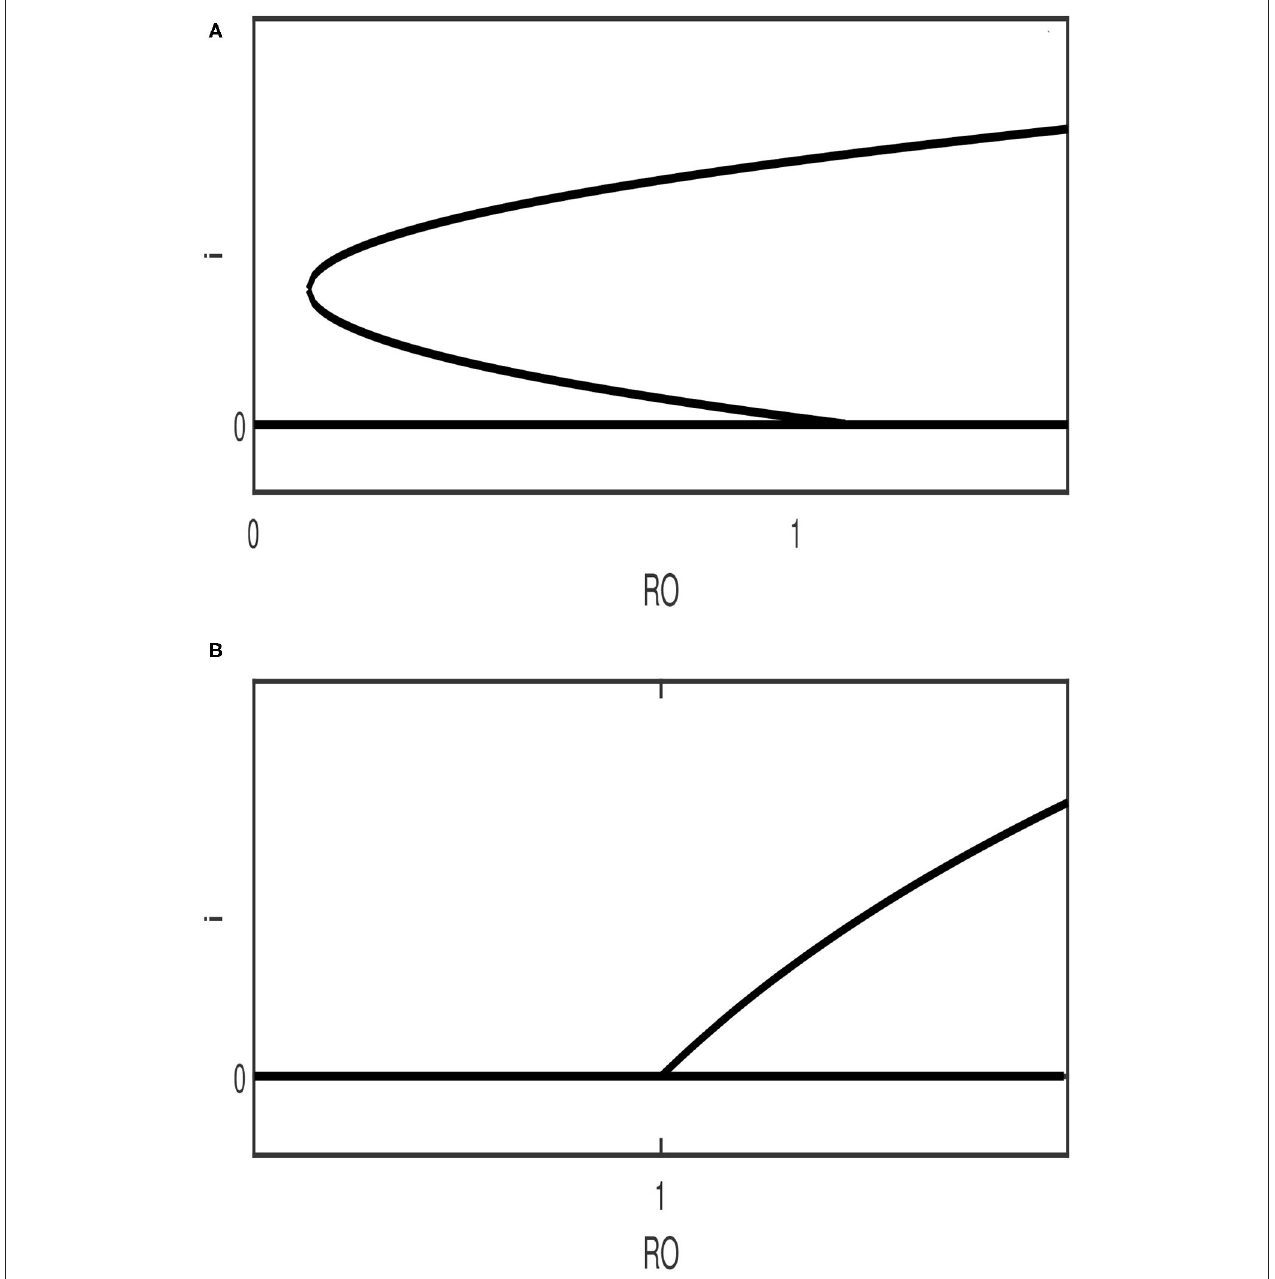
FIGURE 1 | Qualitative diagrams showing the two possible bifurcation behavior expected in the model. (A) backward bifurcation; (B) forward bifurcation (The stability nature of the branches is ignored).